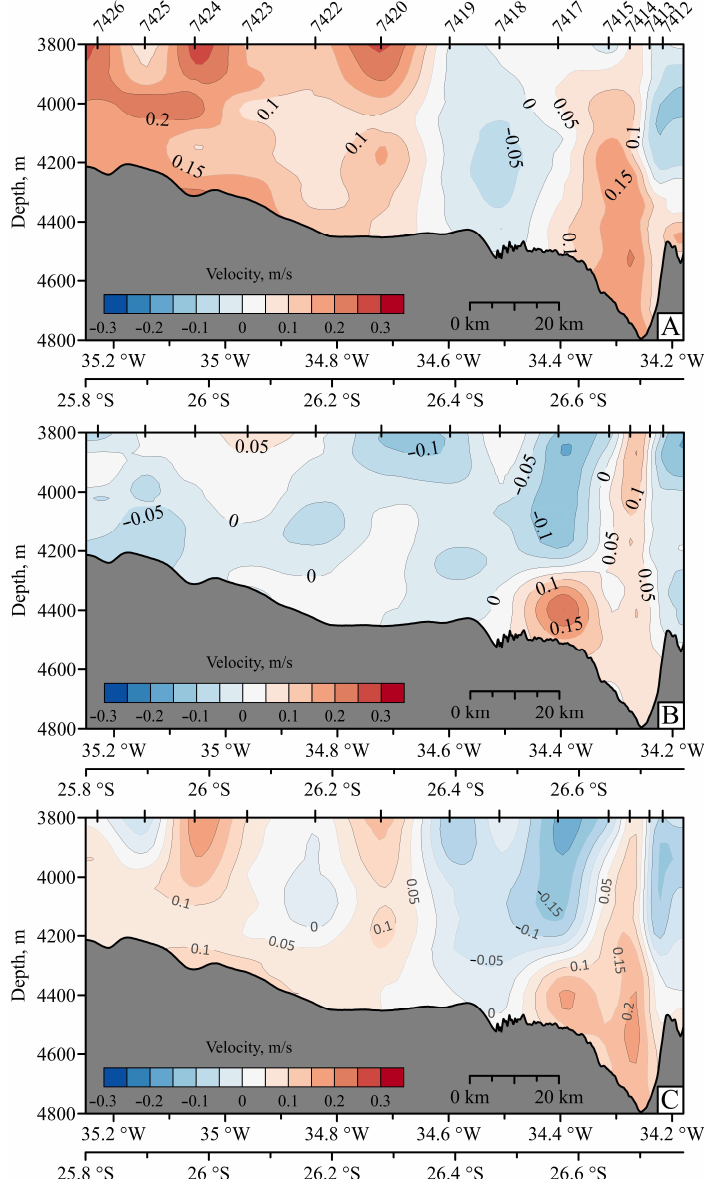
Figure 8. Sections of the velocity components at the outflow of the AABW from the Vema Channel in 2022. Top panel ( A ): positive direction to the east; middle panel ( B ): positive direction to the north; bottom panel ( C ): positive direction to the northeast, normal to the section.